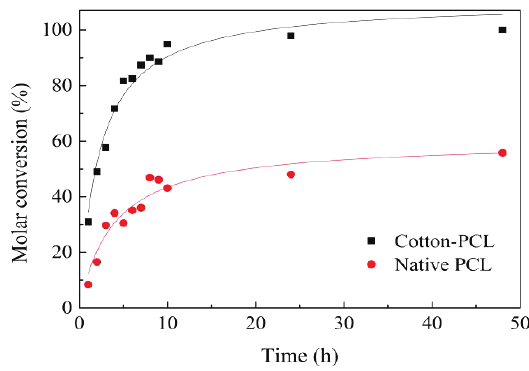
Figure 5: Kinetics of cotton-PCL and native PCL in catalyzing reaction of hexanol with vinyl acetate at 37°C and 160 rpm.